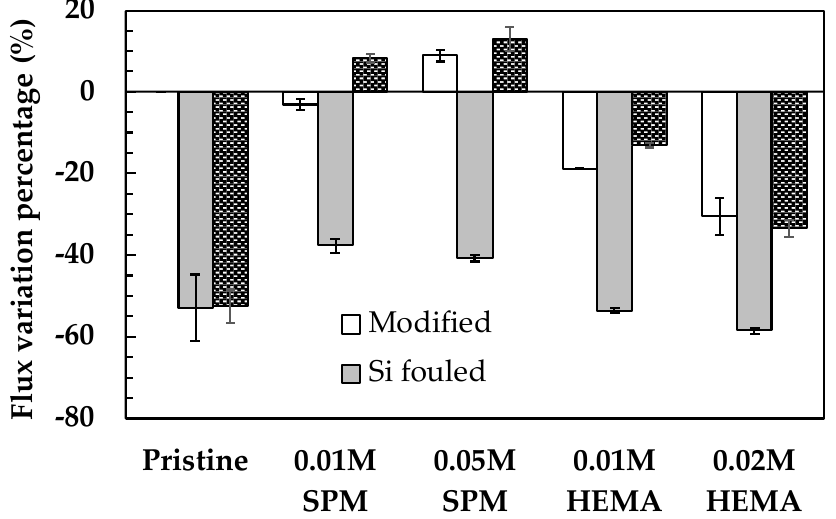
Figure 1. Flux variation of the pristine and modified NF90 after surface modification, silica fouling, and physical cleaning. Error bars represent one standard deviation of triplicate